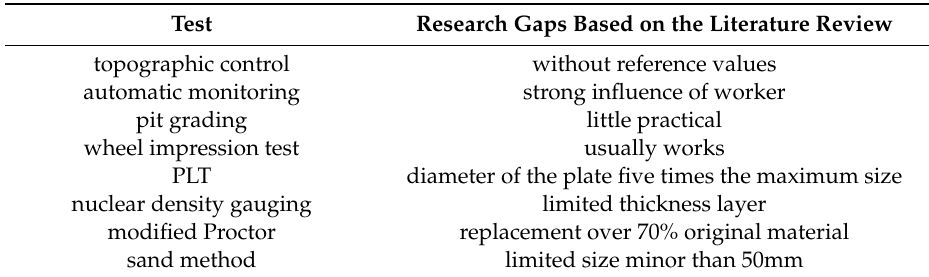
Table 1. Random embankments quality